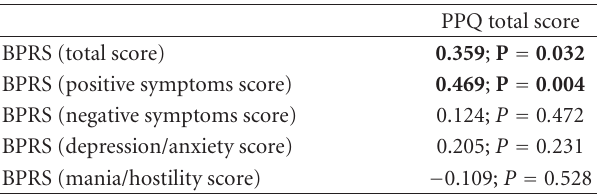
Table 3: Correlations between PPQ total score and BPRS scores (total and subscale scores). Spearman’s rank correlation coe ffi cient was used ( n =